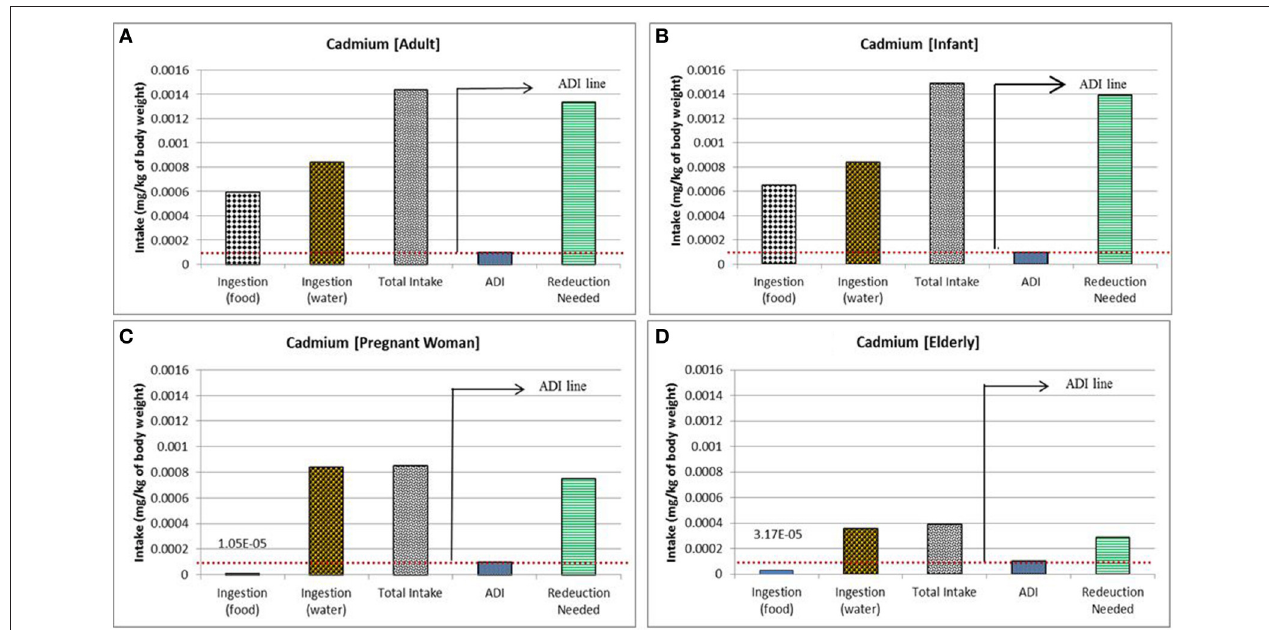
FIGURE 4 | Intake of cadmium to (A) Adult, (B) Infant, (C) Pregnant woman, and (D) Elderly people with necessary reduction needed.